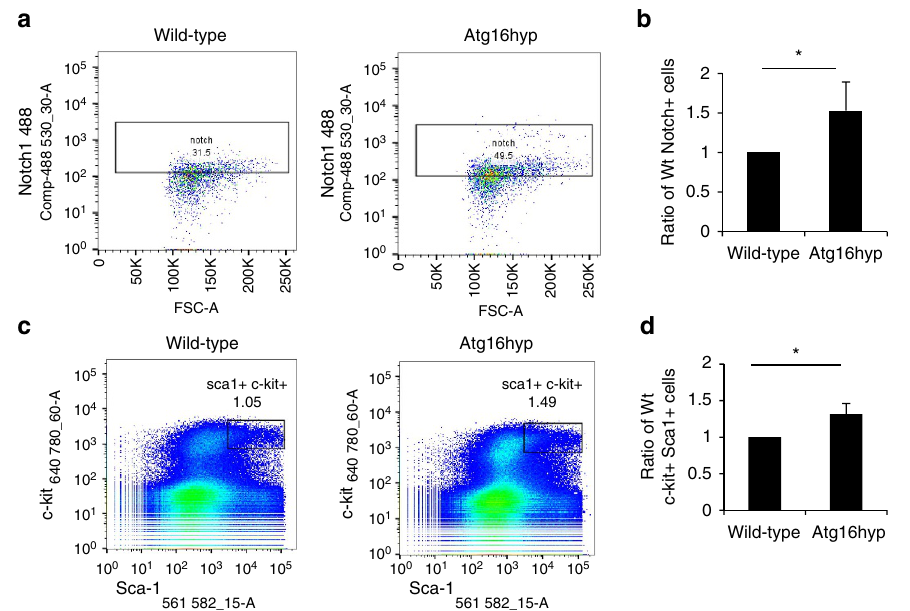
Figure 9 | Delayed bone marrow/gut differentiation in Atg16L1 hypomorphs. ( a ) Dot plots showing representative FACS analysis of Notch1 level in the stem cell population of bone marrow cells isolated from 6 week old wild-type and Atg16hyp mice. Stem cell population was gated and defined as 7AAD-negative, lineage-negative, c-kit-positive and Sca1-positive and Notch1-positive cells. Percentage of stem cells positive for Notch1 above an arbitrary threshold value is shown. ( b ) The per cent of cells staining positive for Notch1 (as described in a ). The graph shows the ratio of Notch1-positive cells gated in Atg16L1 hypomorph (Atg16hyp) to wild-type (Wt) gated cells. * P o 0.5 by paired t -test. n ¼ 6. Error bars ¼ s.e.m. ( c ) Effect of decreased ATG16L1 levels on differentiation of bone marrow stem cells. Representative dot plots from FACS analysis of bone marrow cells from 6 weeks old wild-type and Atg16L1 hypomorph (Atg16hyp) mice. The black box indicates the gated population identified as stem cells, defined as 7AAD-negative, lineage-negative, c-kit-positive and Sca1-positive cells. ( d ) Quantification of gated population of stem cells as illustrated in c. The ratio of Atg16L1 hypomorph (Atg16hyp) gated cells to wild-type (Wt) gated cells is shown. * P o 0.5 by paired t -test. n ¼ 9. Error bars ¼